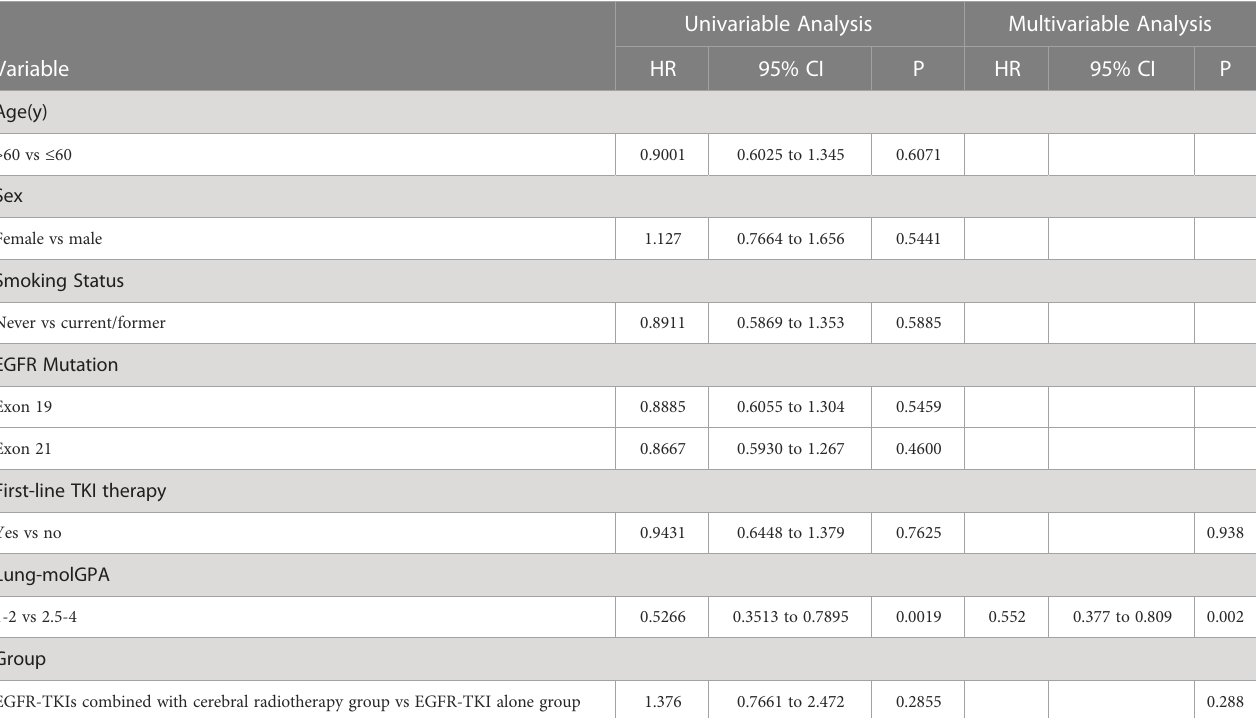
TABLE 2 Univariable and multivariable analyses of covariables associated with ipfs.